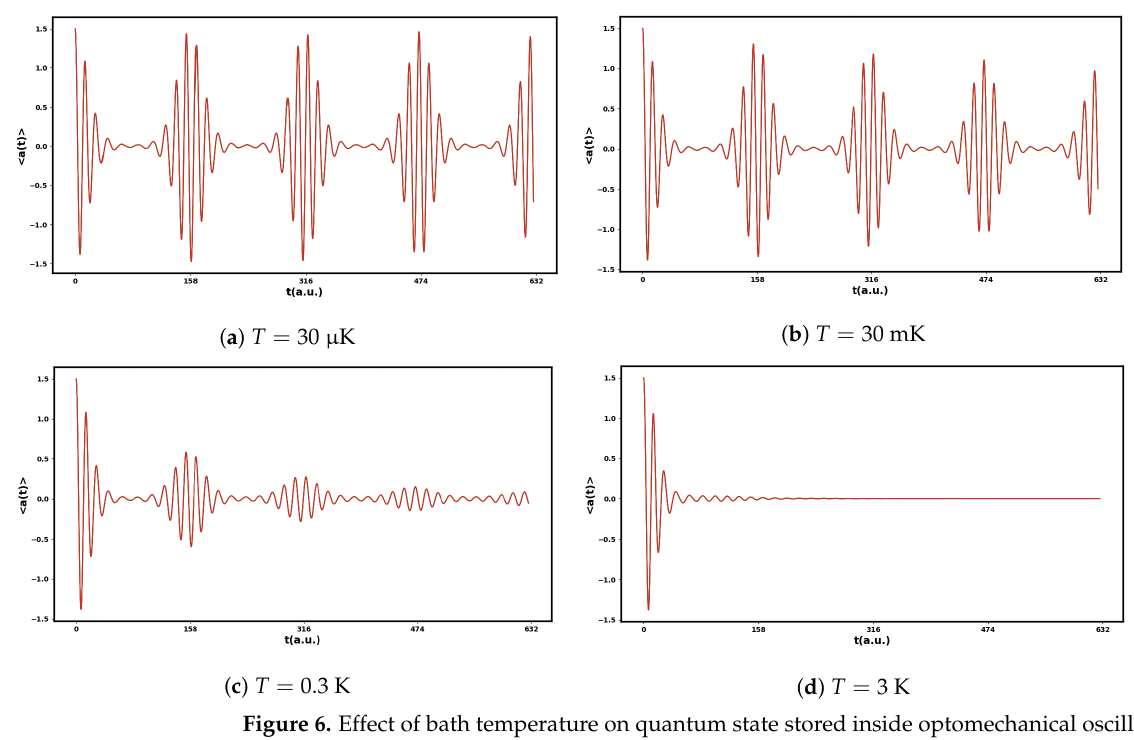
Figure 6. Effect of bath temperature on quantum state stored inside optomechanical oscillator with nonlinearities k c = k m = 0.01 a.u. and dissipation γ c = γ m = 0.00001 a.u. The amplitudes of revived states at their revival time are recorded for various values of bath temperature T